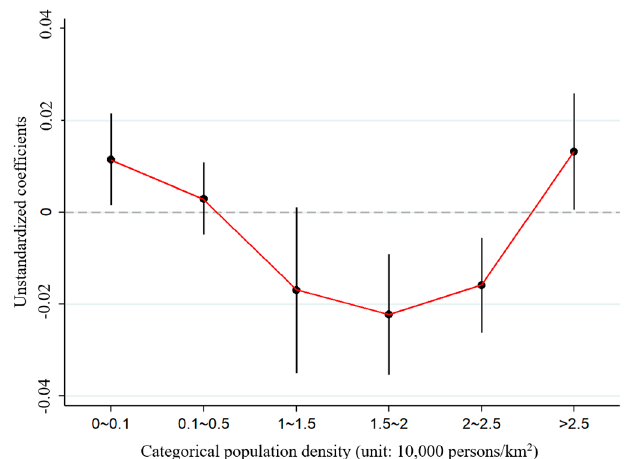
Figure 1. The U-shaped e ff ect of population density on waist–hip ratio. Note: The vertical lines Figure 1. the U-shaped effect of population density on waist–hip ratio. Note: The vertical lines represent 95% confidence intervals of the coe ffi represent 95% confidence intervals of the coefficients.